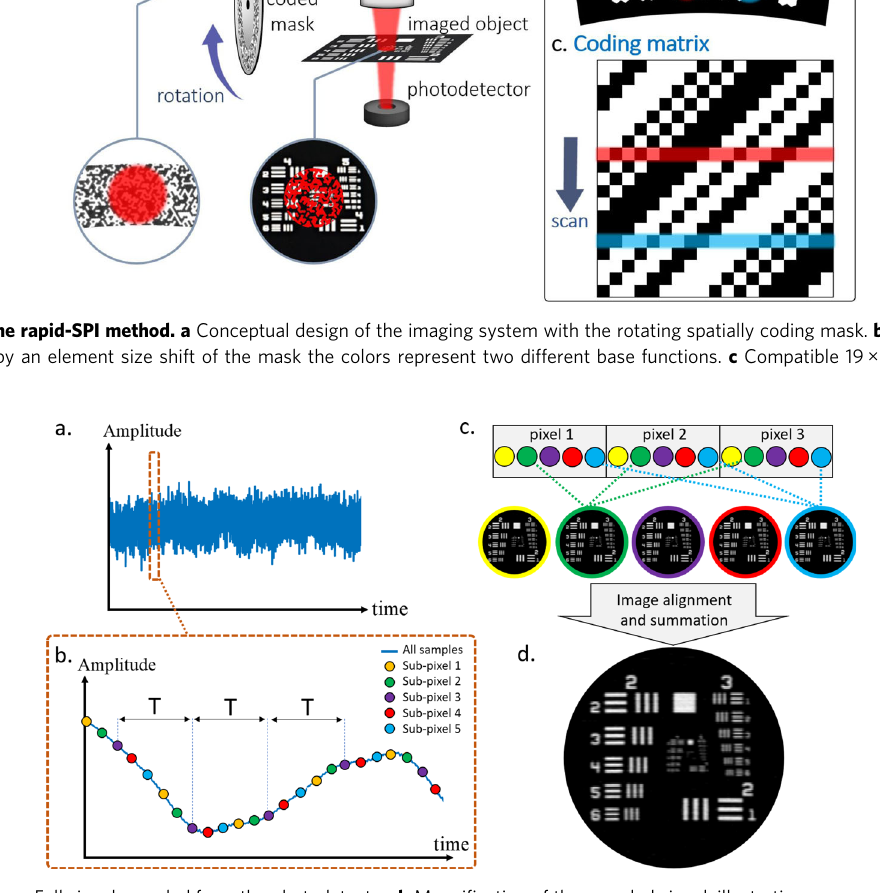
Fig. 2 Image formation. a Full signal sampled from the photodetector. b Magni fi cation of the sampled signal, illustrating over-sampling by a factor of M = 5, i.e., during the transition time between neighboring basis functions, T , which corresponds to a shift of a single pixel between the mask and imaged object, M samples are acquired. Sampled points separated by T appear in the same color in fi gure ( c ). For a mask with N basis functions, one obtains M datasets with N sampled points each. Each dataset is used to produce its own version of the image by using an FFT-based reconstruction algorithm, where the M reconstructions are identical up to sub-pixel shifts. d The fi nal image is obtained by applying sub-pixel shifts to align the M reconstructions and summing the aligned images.